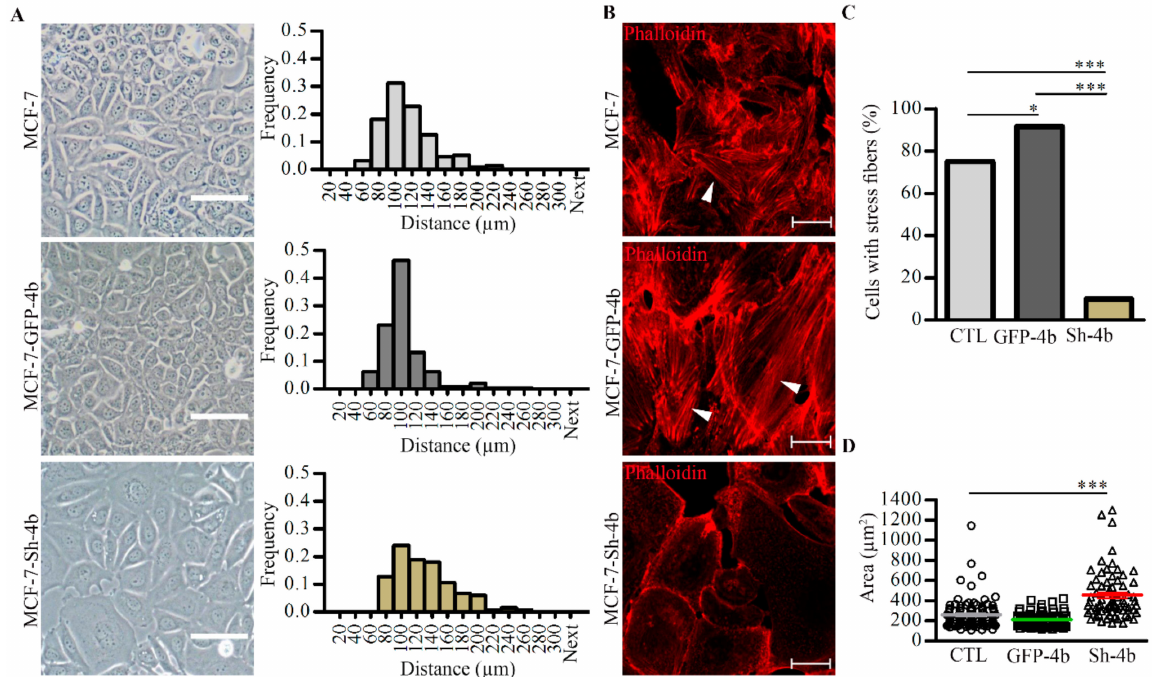
Figure 5. PMCA4b silencing in MCF-7 cells changed cell culture morphology and resulted in a dramatic loss of stress fibers. ( A ) Phase contrast images of MCF-7 cells, GFP-PMCA4b (MCF-7-GFP-4b), or shRNA of PMCA4b (MCF-7-Sh-4b). Scale bar, 50 µ m. The distance between nearest neighbors was determined using the binary images of cell centers. ( B ) F-actin in the three cell types was labeled with Phalloidin-TRITC. Arrowheads show stress fibers. Scale bar, 20 µ m. The fractions of stress fiber-positive cells were determined ( n = 48, 83, and 100, respectively) ( C ) and the area of individual cells of the phase contrast images was calculated ( n = 100, 88, and 70, respectively) ( D ). Bars represent the mean values for each cell type (* p < 0.05, *** p <